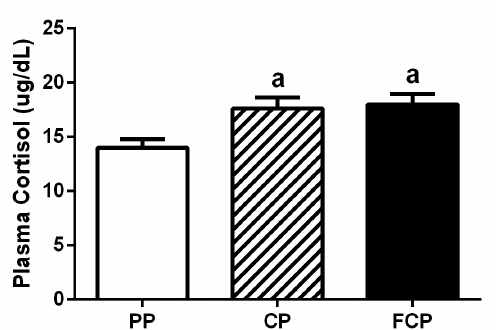
Figure 1. Effect of selective loads periodization on plasma cortisol of female futsal players in the onset of the preparatory (PP), competitive (CP) and final competitive period (FCP). Values are expressed as mean ± SD. a p < .01 compared with the PP.